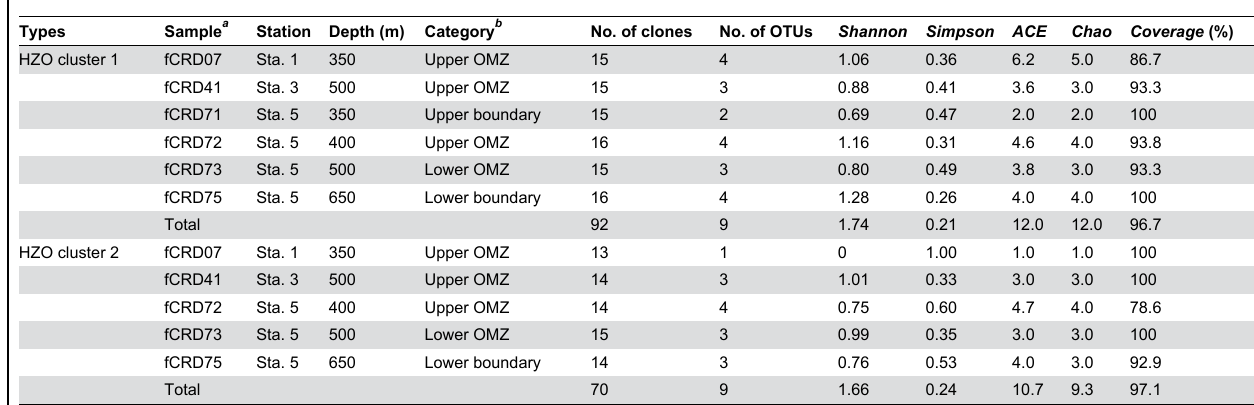
Category names were defined in the first paragraph in the